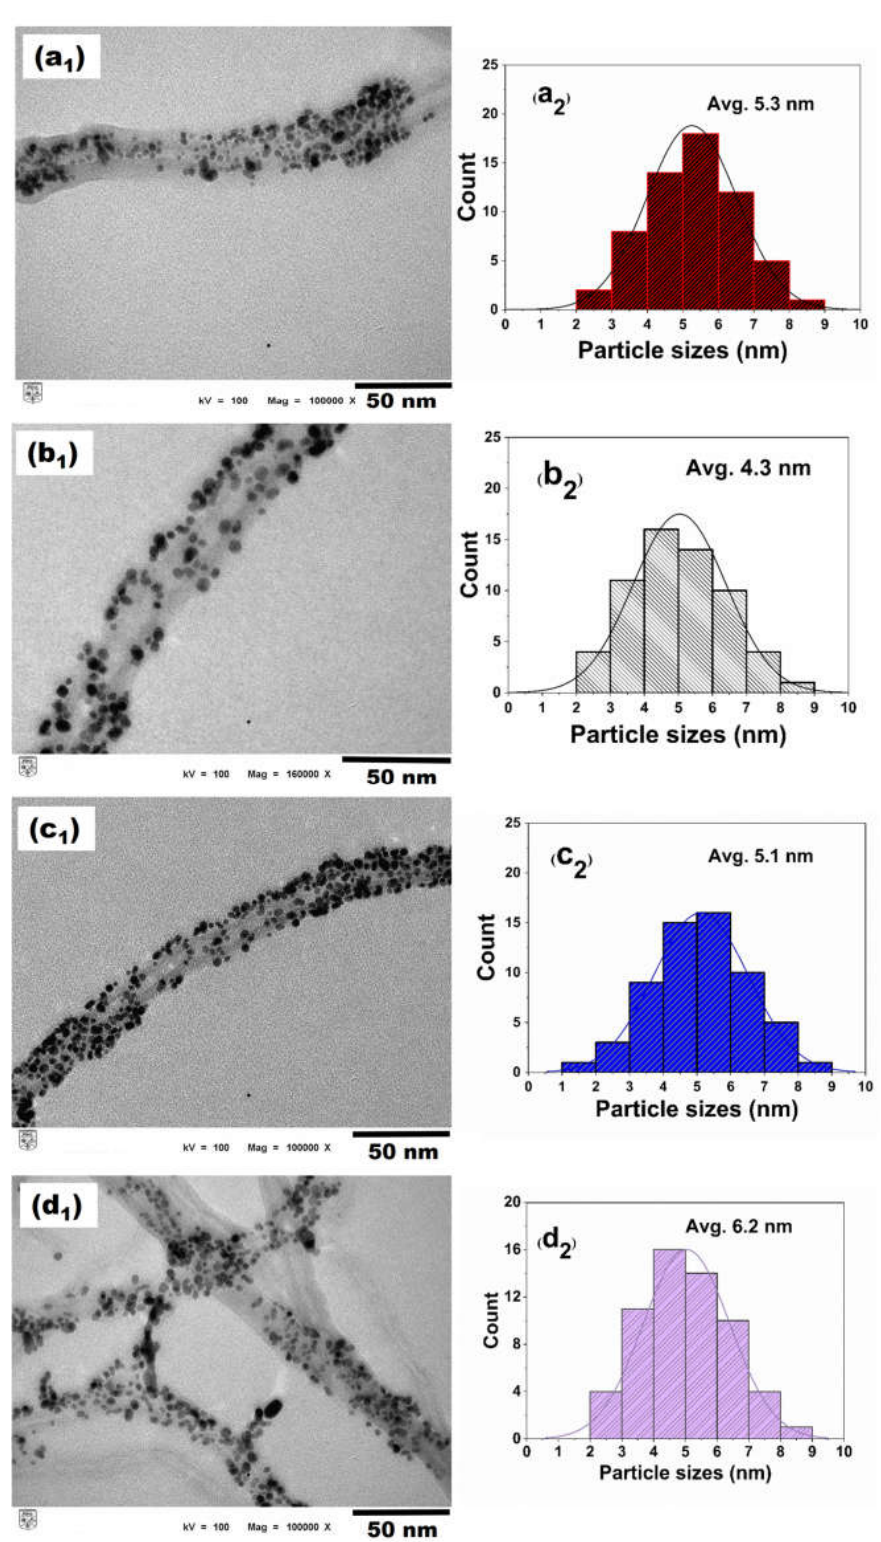
Figure 2. TEM images of various electrocatalysts: ( a 1 ) MWCNT-Pt; ( b 1 ) MWCNT-PBI-Pt; ( c 1 ) MWCNT-Nafion-Pt; and ( d 1 ) MWCNT-PTFE-Pt. Pt nanoparticle distribution sizes of ( a 2 ) MWCNT-Pt; ( b 2 ) MWCNT-PBI-Pt; ( c 2 ) MWCNT-Nafion-Pt; and ( d 2 ) MWCNT-PTFE-Pt electrocatalysts.